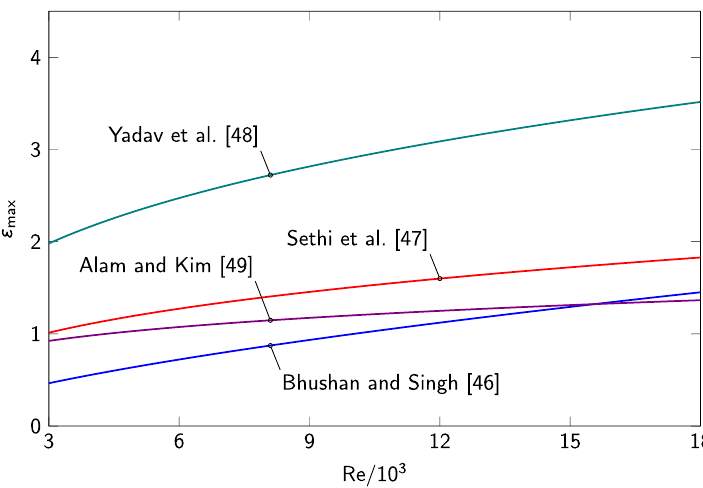
Figure 15. Relationship between η max and Re for absorber plates with round obstacles and ˙ G = 1000Wm − 2 .